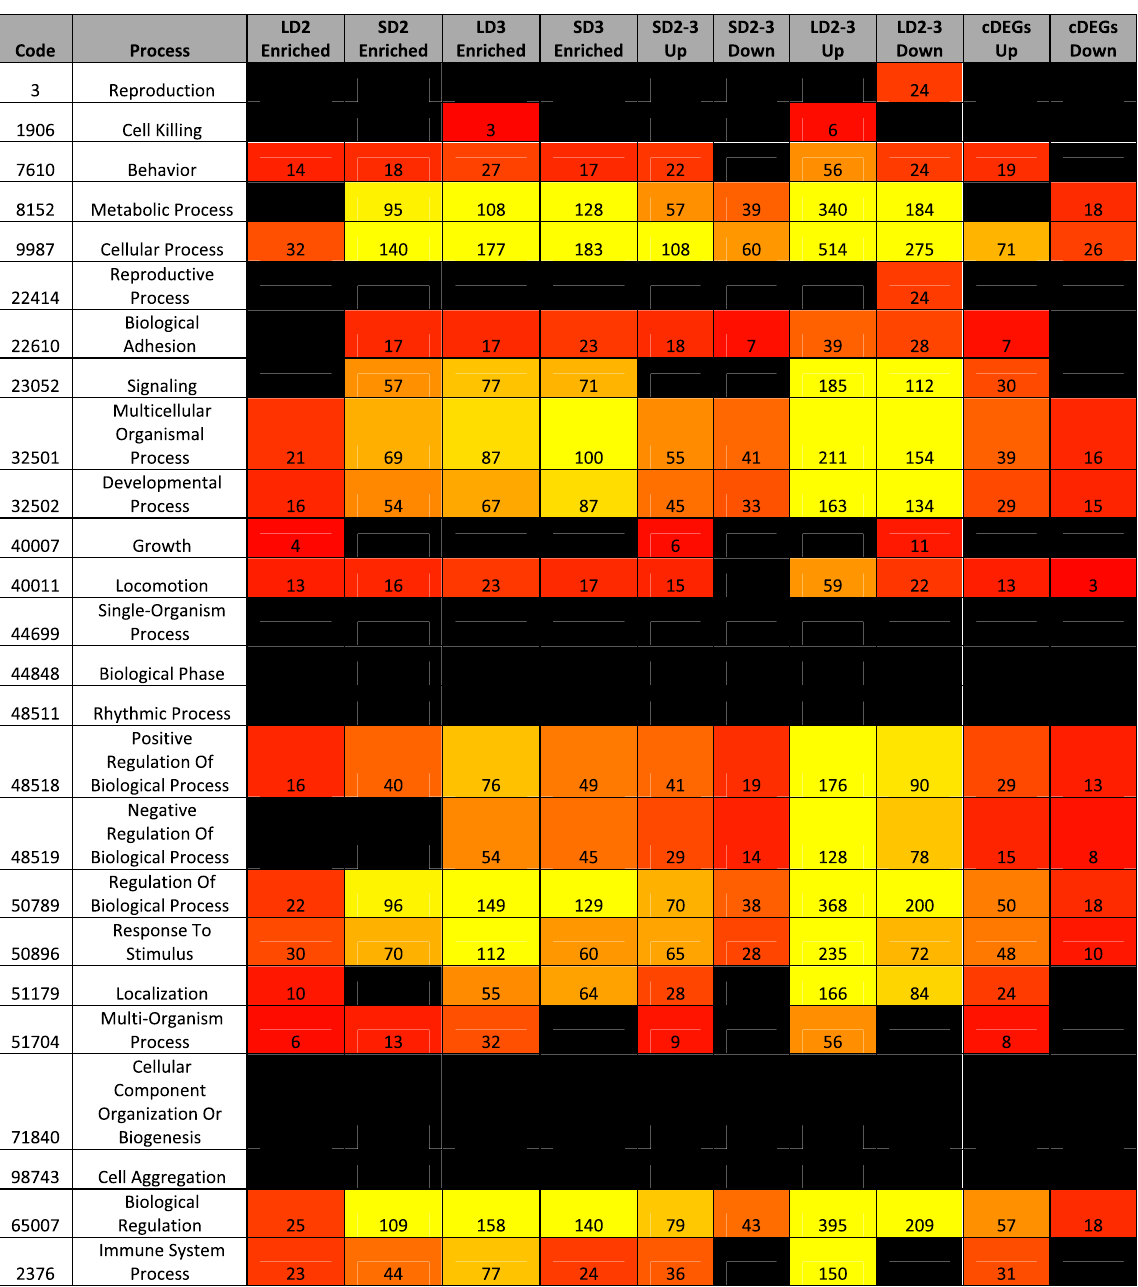
Table 1. Enrichment of gene ontology biological processes specific for mice based upon differentially expressed gene groupings. Enrichment of primary (tier 1) biological functions from the gene ontology (BINGO 32,33 ) based upon differentially expressed genes in the steroid and chemotherapeutic models of invasive pulmonary aspergillosis from day to day 3. LD, chemotherapeutic model; SD, steroid model; 2–3, from day 2 to 3; Up, differentially expressed genes increasing in expression; Down, differentially expressed genes decreasing in expression; Enriched, differentially expressed genes of higher transcript expression for the identified model in comparison to the alternate model for a given day; cDEGs Up, differentially expressed genes increasing in expression from day 2 to day 3 in both models; cDEGS Down, differentially expressed genes decreasing in expression from day 2 to day 3 in both models. Color code gradient from null (black) to 1 (red) to 100